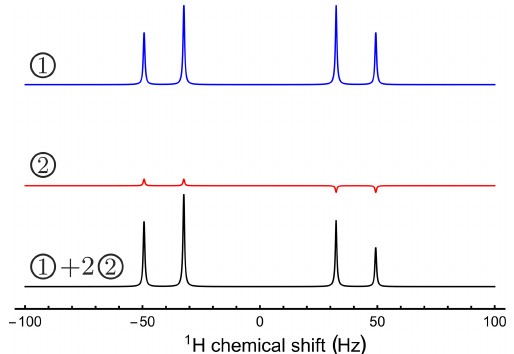
Figure B1. The origin of the asymmetry observed in Fig. 2. The simulated spectra show signals generated by two different density operators, excited by an identical π/ 2 pulse. The first initial state corresponds to pure longitudinal magnetization. The second initial state corresponds to a singlet order secularized under the Hamilto- nian given in Eq. (B1). A suitably weighted superposition of the two spectra is a good match to the experimental